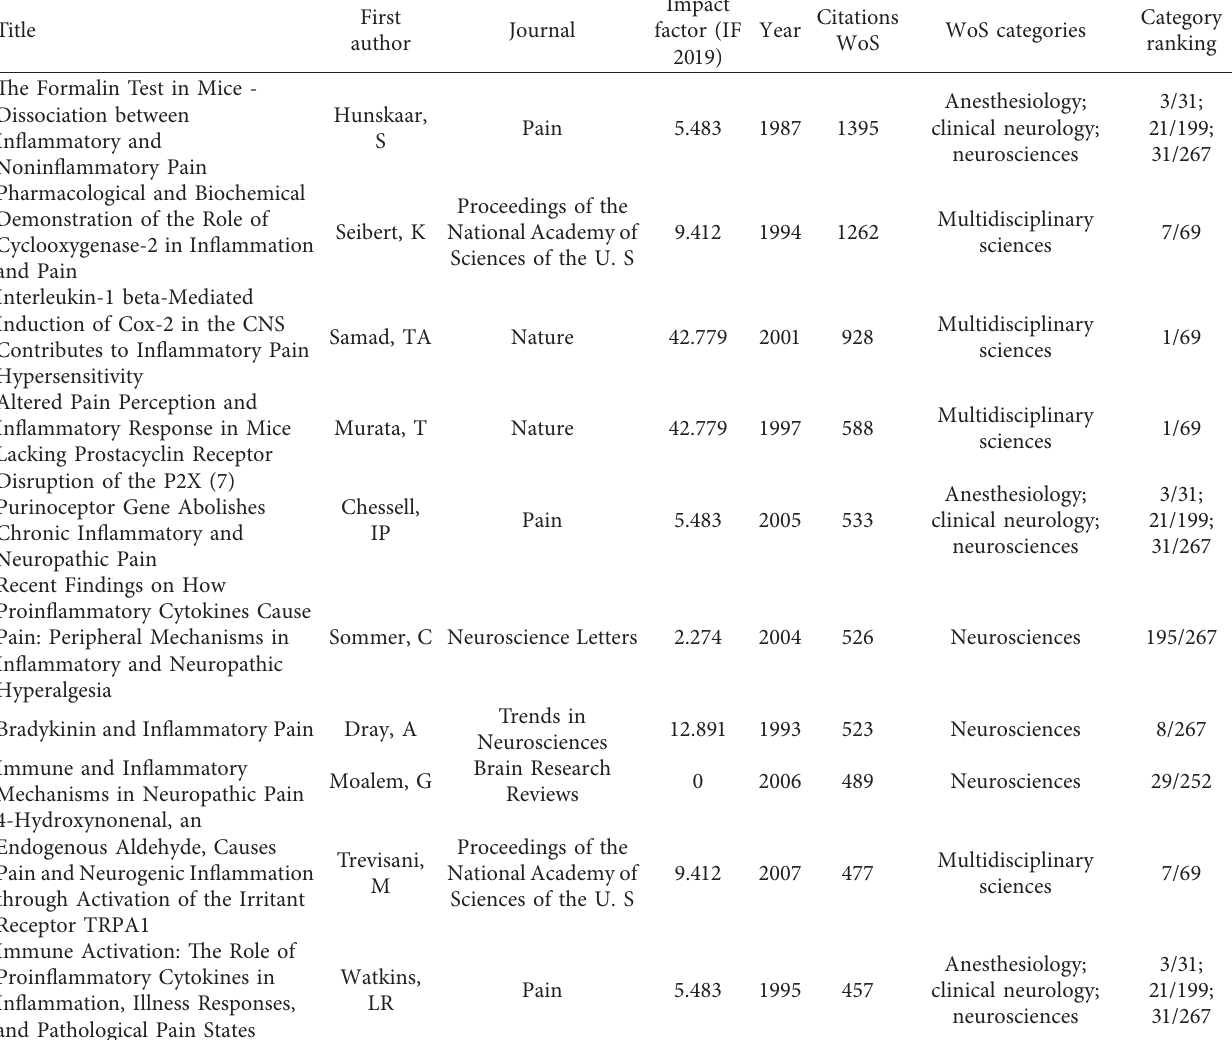
Table 2: The top 10 papers with the most citation frequency in the pain and inflammation